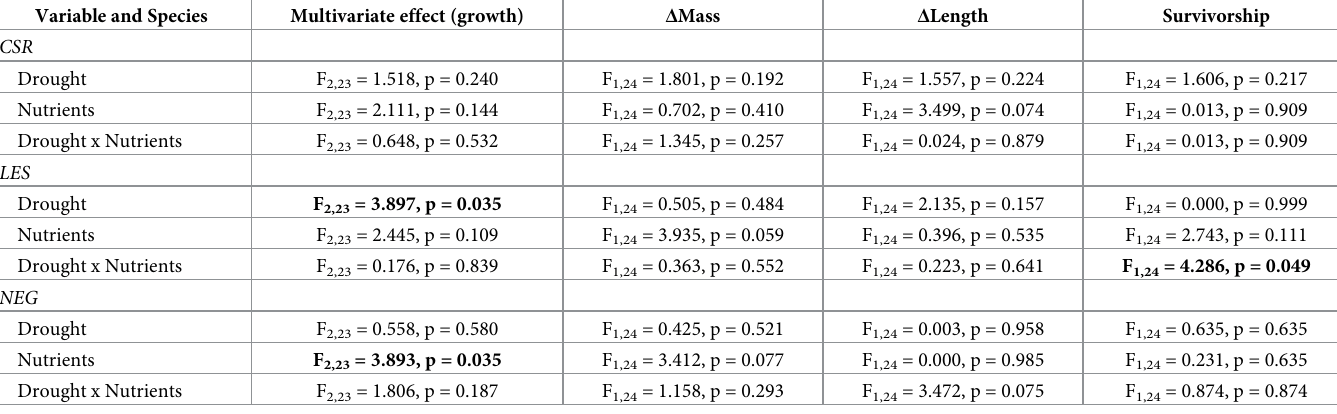
Table 1. Probability values associated with multivariate analysis of variance (MANOVA) for the effect of drought and nutrient enrichment on multivariate change of growth (change in mass and length) and analysis of variance (ANOVA) for the effect of drought and nutrient enrichment on change in length, change in mass, and survival of Central Stoneroller (CSR), Longear Sunfish (LES), and Ringed Crayfish (NEG).